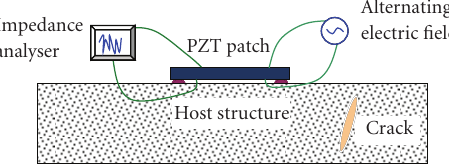
Figure 1: The sketch of a PZT patch bonded onto a damaged structure.